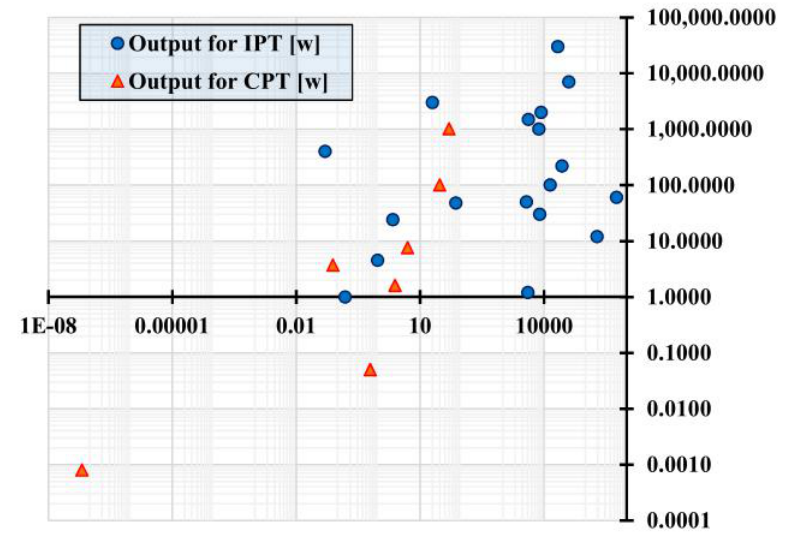
Figure 8. Graph of OUTPUT POWER vs. COUPLER VOLUME (mm 3 ).